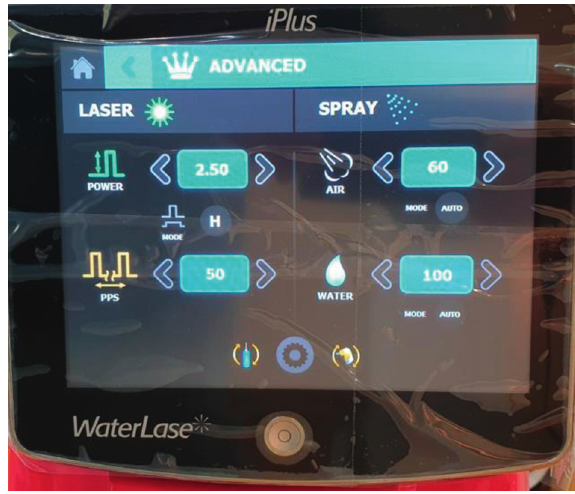
Figure 1: The settings showing on the screen of the Er Cr: YSGG laser machine.